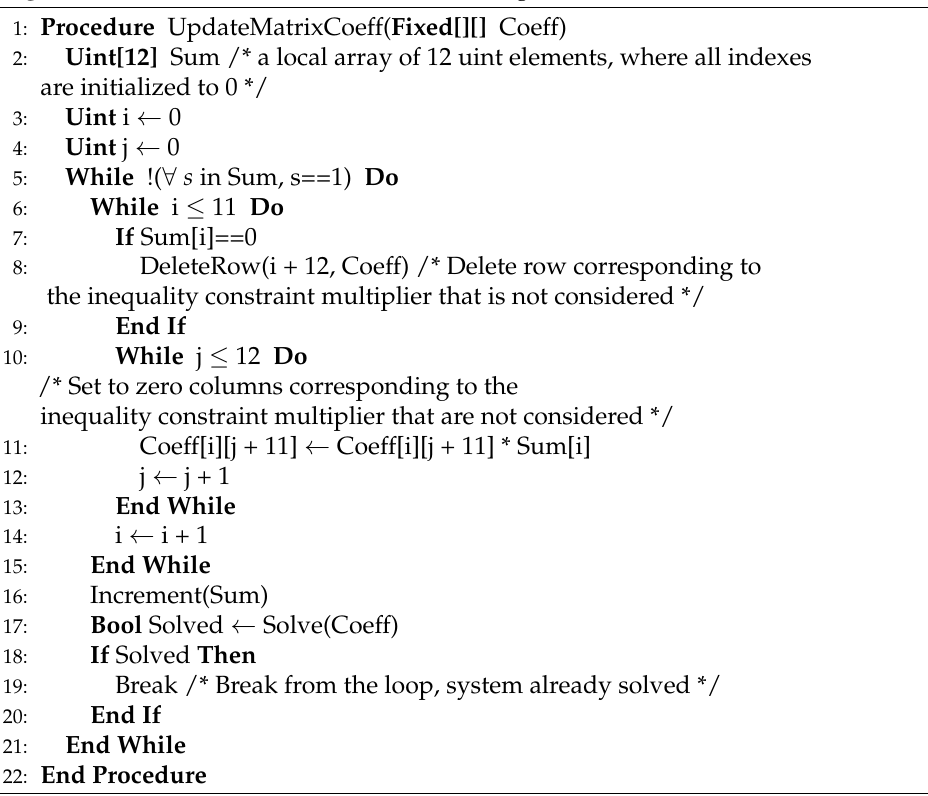
Algorithm 2 OPF Solver Smart contract: Solving DC-OPF matrix (main